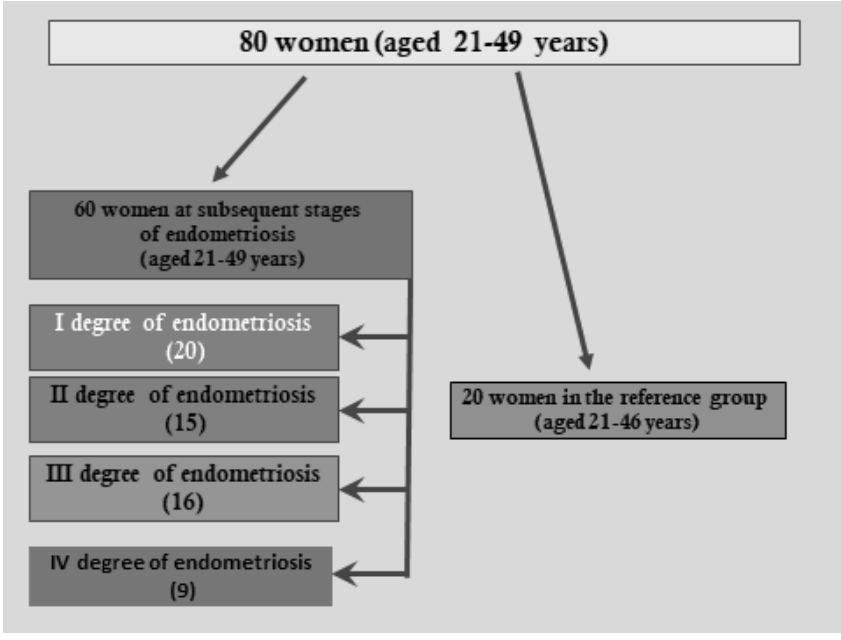
Figure 2. Women at subsequent stages of endometriosis and women in the reference group.